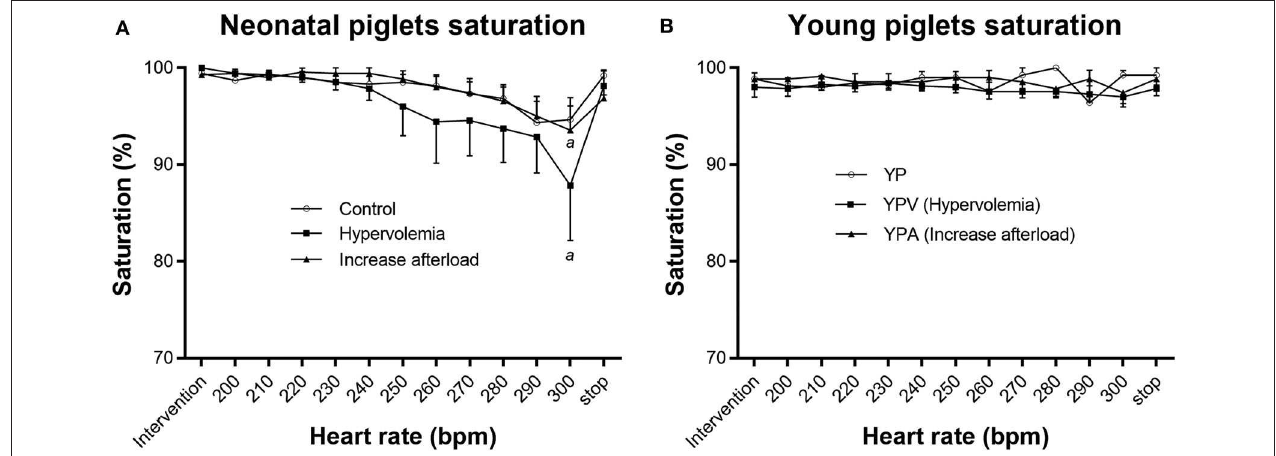
FIGURE 3 | Saturation through pacing protocol. Pacing affected oxygen saturation levels in NPV (hypervolemia) and NPA (increase afterload) groups (Friedman test p < 0.001 for both) (A) . Pacing did not affect saturation in the YP groups (B) . Paired comparisons based on Wilcoxon Signed Rank Sum test ( p < 0.05). a Different from before pacing protocol value ( p <